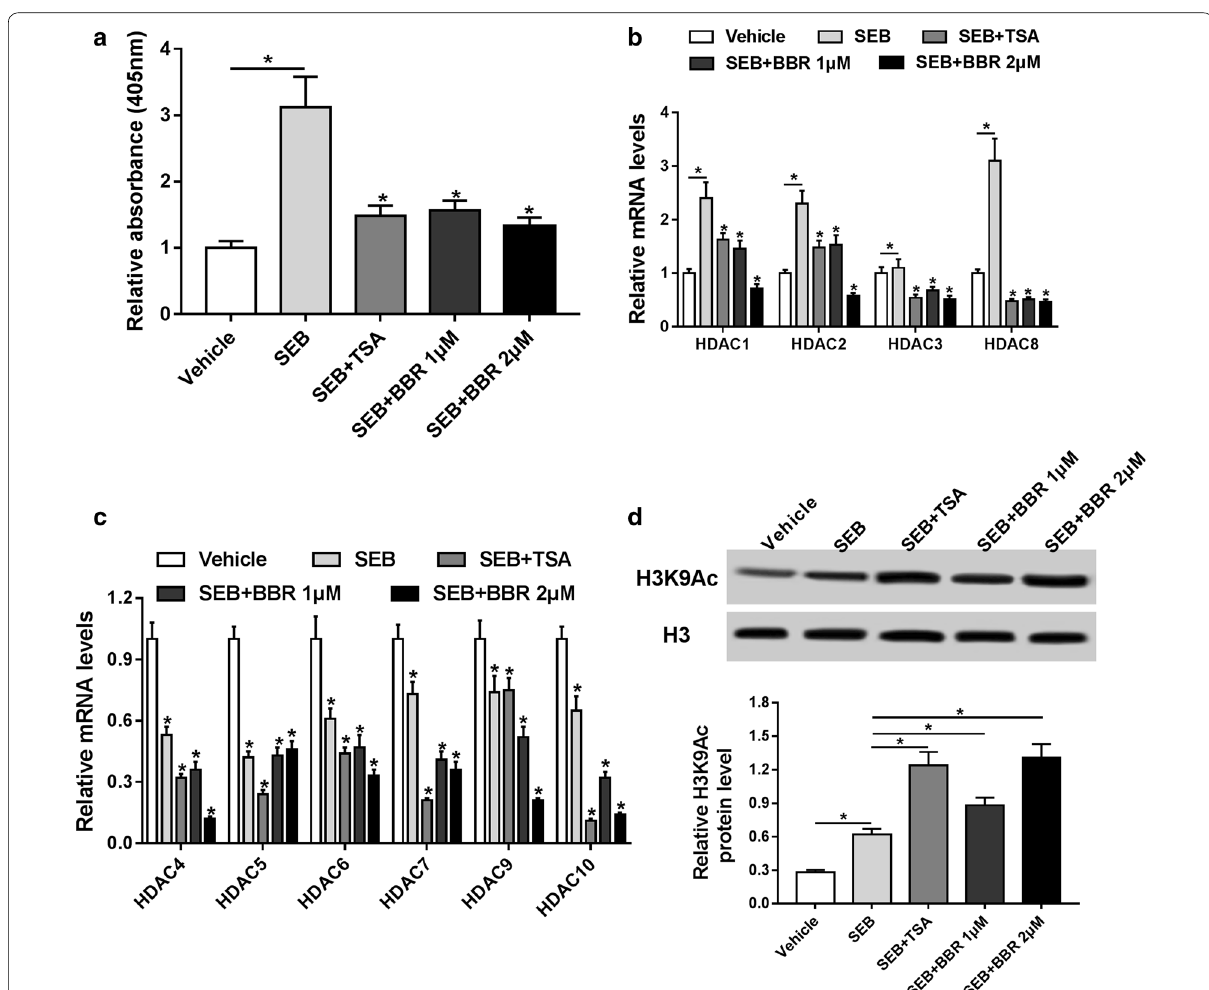
Fig. 4 BBR was effective at downregulating class I HDAC after activation of SEB. Splenocytes were treated with SEB, in the absence or presence of 1 or 2 μM BBR or 100 nM TSA for 24 h. a The HDAC activity was investigated by colorimetric analysis. b , c The mRNA expression of class I and II HDAC enzymes was detected in the treated splenocytes by qRT-PCR analysis. d The protein levels of H3K9Ac were examined by western blot in the treated splenocytes. * P < 0.05. SEB group versus Vehicle or SEB BBR or SEB TSA group, + +